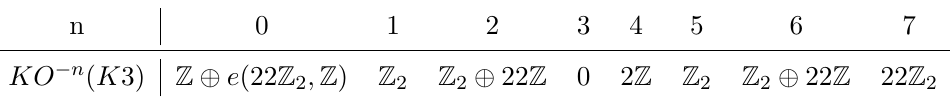
Table 33 . KO-groups of K3, KO − n ( K 3)